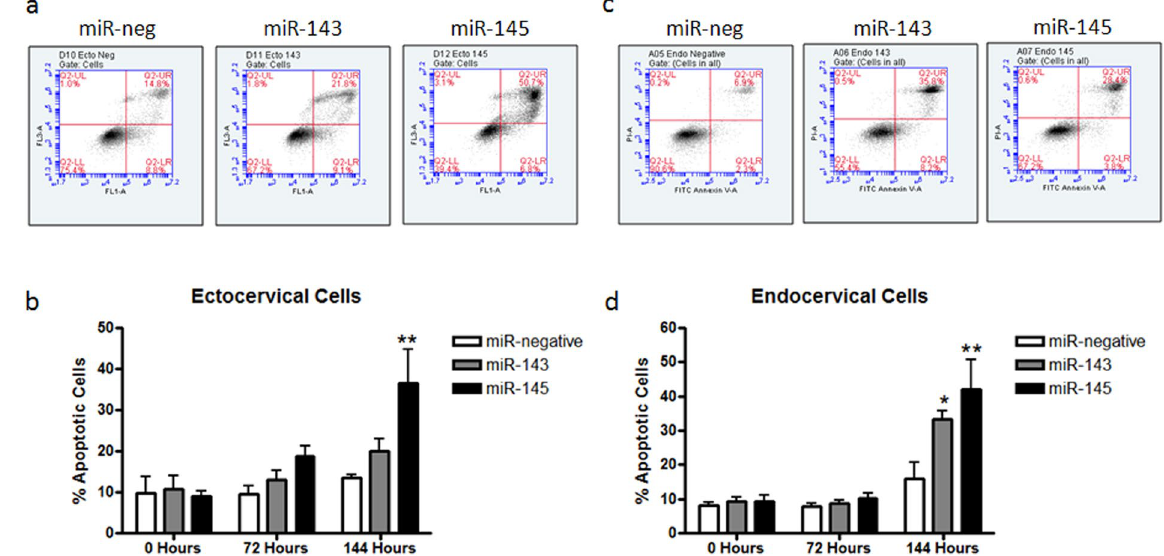
Figure 5. miR-143 and miR-145 increased ectocervical and endocervical cell apoptosis. Flow cytometry based annexin V/PI apoptosis assays were performed on ectocervical and endocervical cells transfected with miR-negative control (miR-neg), miR-143 or miR-145 at 0, 72 and 144 hours after transfection. Representative histograms showing the results of the apoptosis assay are depicted for each miRNA at 144 hours in ectocervical ( a ) and endocervical ( c ) cells. The results from four independent assays are shown in the bar graphs. In ectocervical cells, miR-145 significantly increased the percentage of apoptotic cells ( b ) while, in endocervical cells, both miR-143 and miR-145 increased the percentage of apoptotic cells ( d ) at 144 hours. Values are mean ± SEM * p < 0.05, ** p <